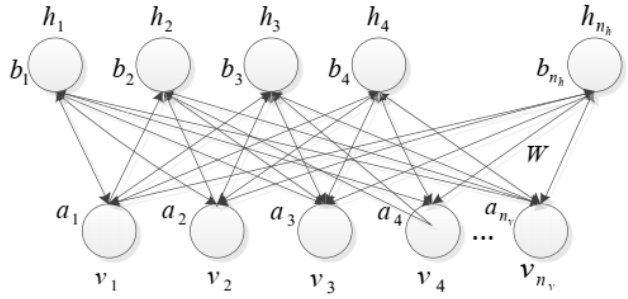
Figure 3. Restricted Boltzmann machine architecture.